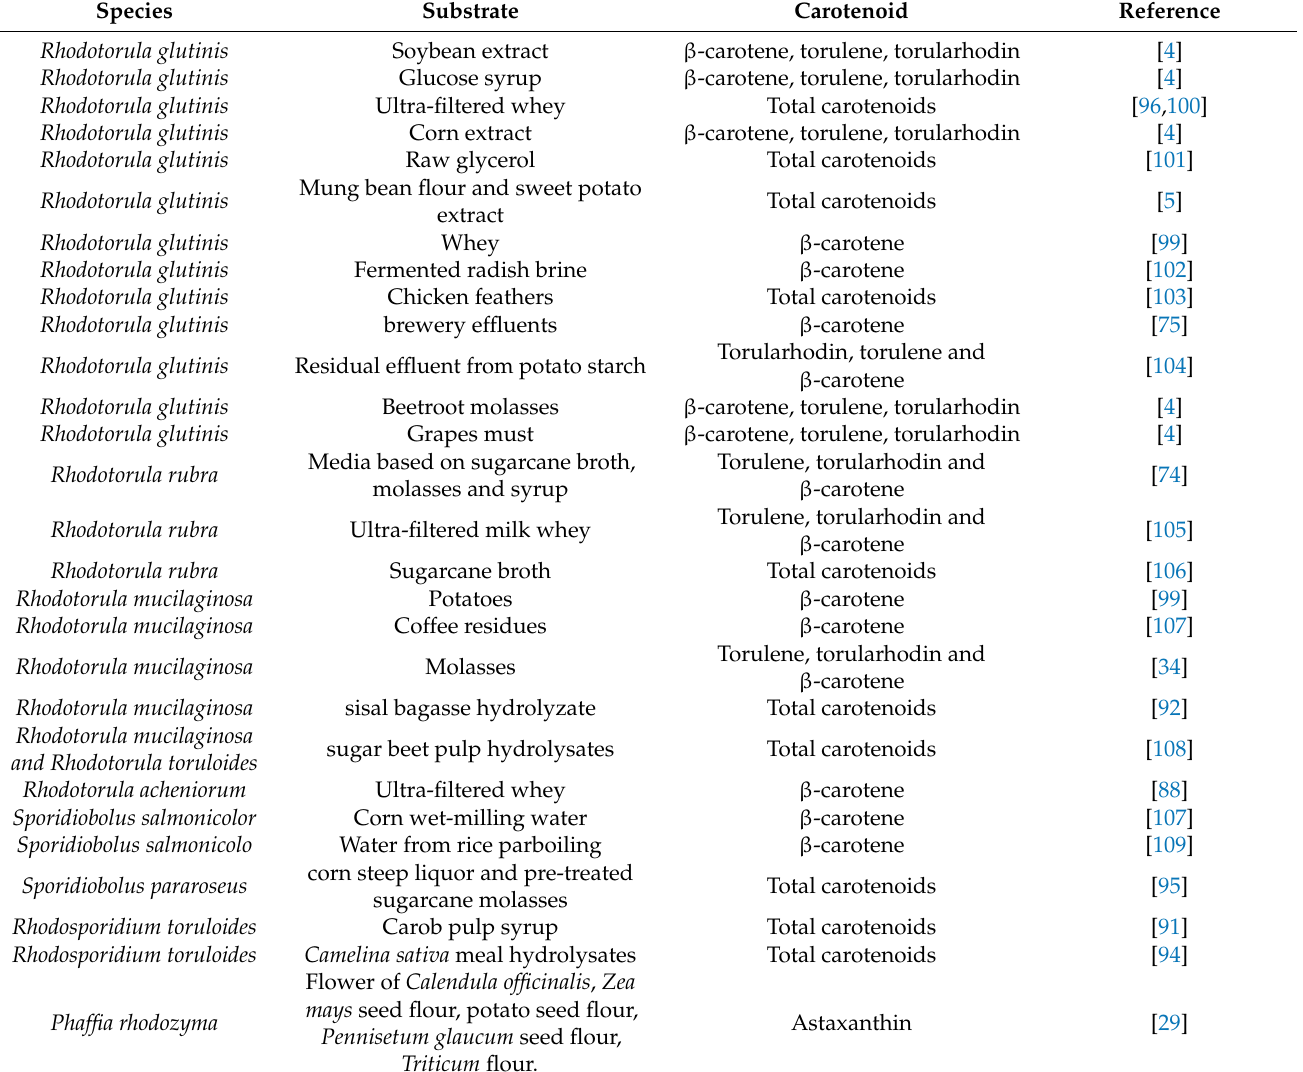
Table 5. Agroindustrial residues investigated as substrates for carotenoids production by